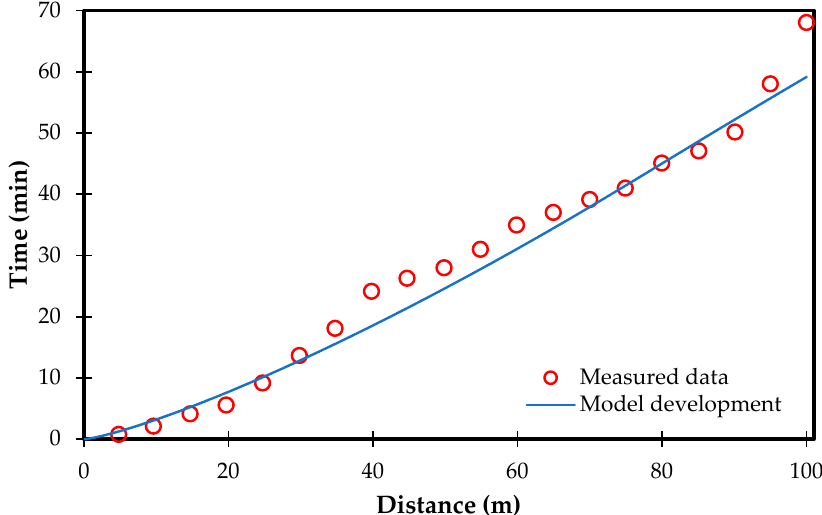
Figure 5. Evolution of the advance front in the second irrigation test.